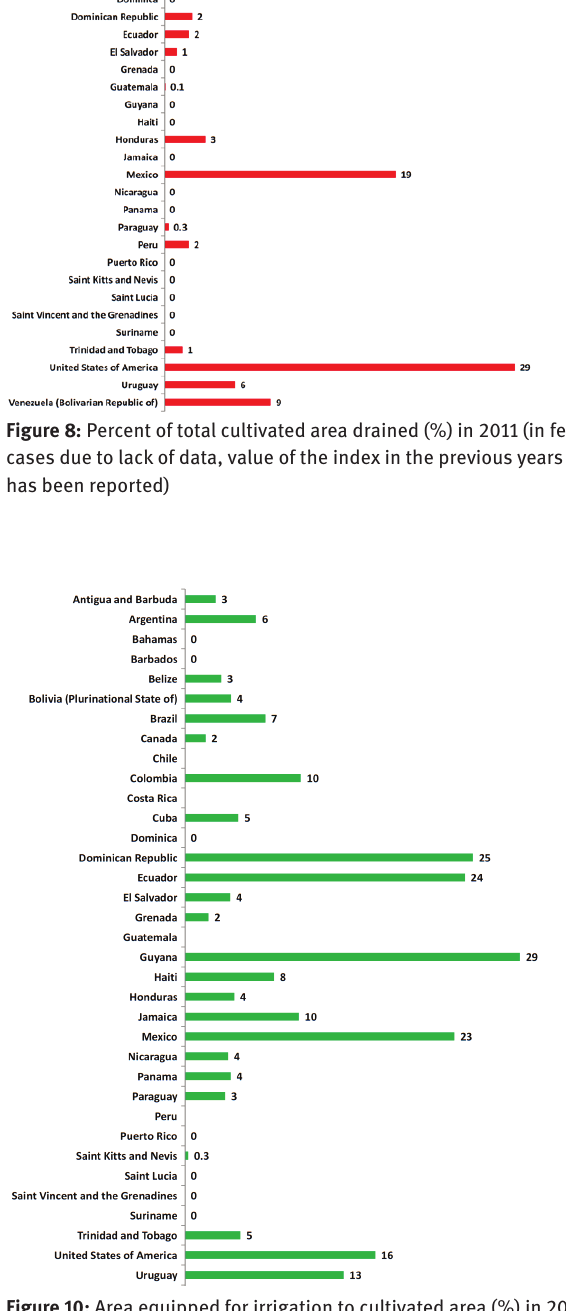
Figure 10: Area equipped for irrigation to cultivated area (%) in 2011 this index is not available for Chile, Costa Rica, Guatemala, and Peru (in few cases due to lack of data, value of the index in the previous years has been